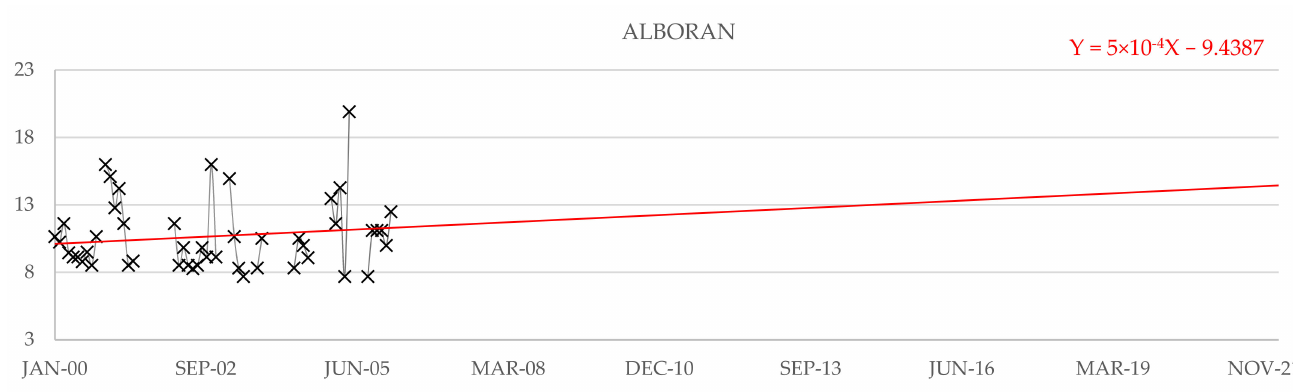
Figure 11. Evolution of Tp maxima in the Gulf of Cadiz.